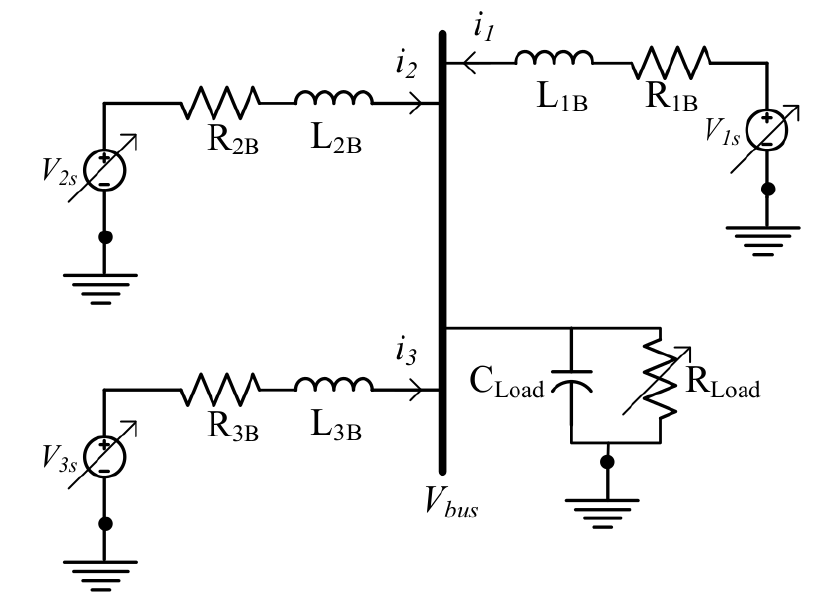
Figure 3. Example microgrid used in simulation for patrol base (PB) demonstration of droop control methods.